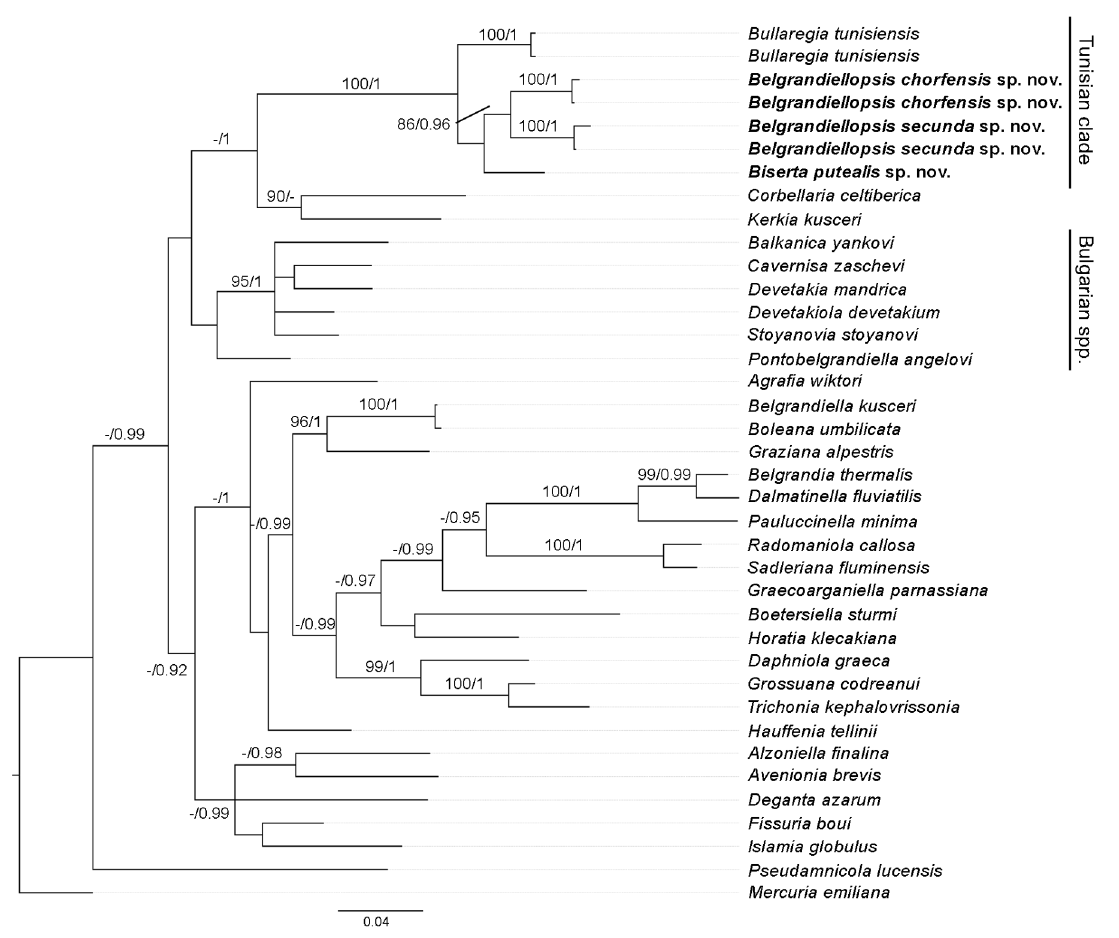
Fig. 2. Bayesian inference based on the COI and 18S datasets. Bootstrap values and BPP’s for branches are given when ≥ 70% and ≥ 0.90, respectively. Scale bar = expected change per